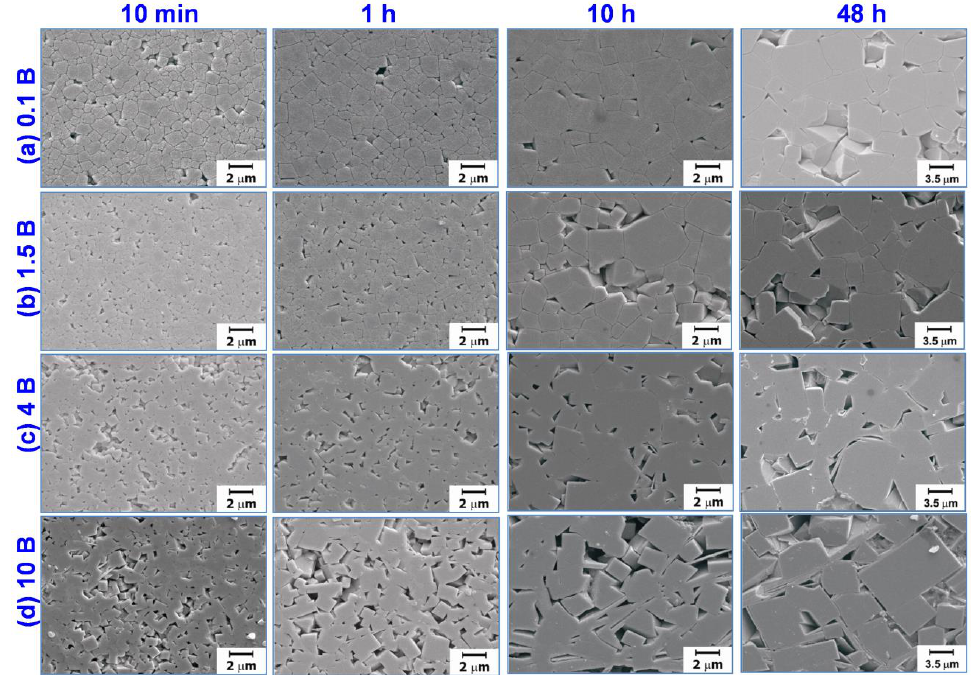
Figure 2. Scanning electron microscopy (SEM) micrographs of ( a ) 0.1 mol%, ( b ) 1.5 mol%, ( c ) 4 mol%, and ( d ) 10 mol% Bi 2 O 3 -excess 0.95(Na 0.5 Bi 0.5 )TiO 3 -0.05BaTiO 3 (NBT–5BT) samples sintered at 1200 °C for various sintering times.